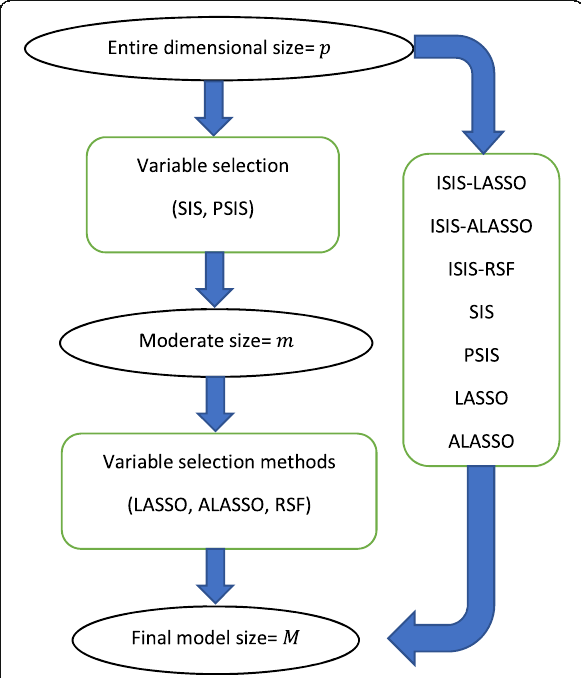
Fig. 1 Overall diagram of the screening approaches and the